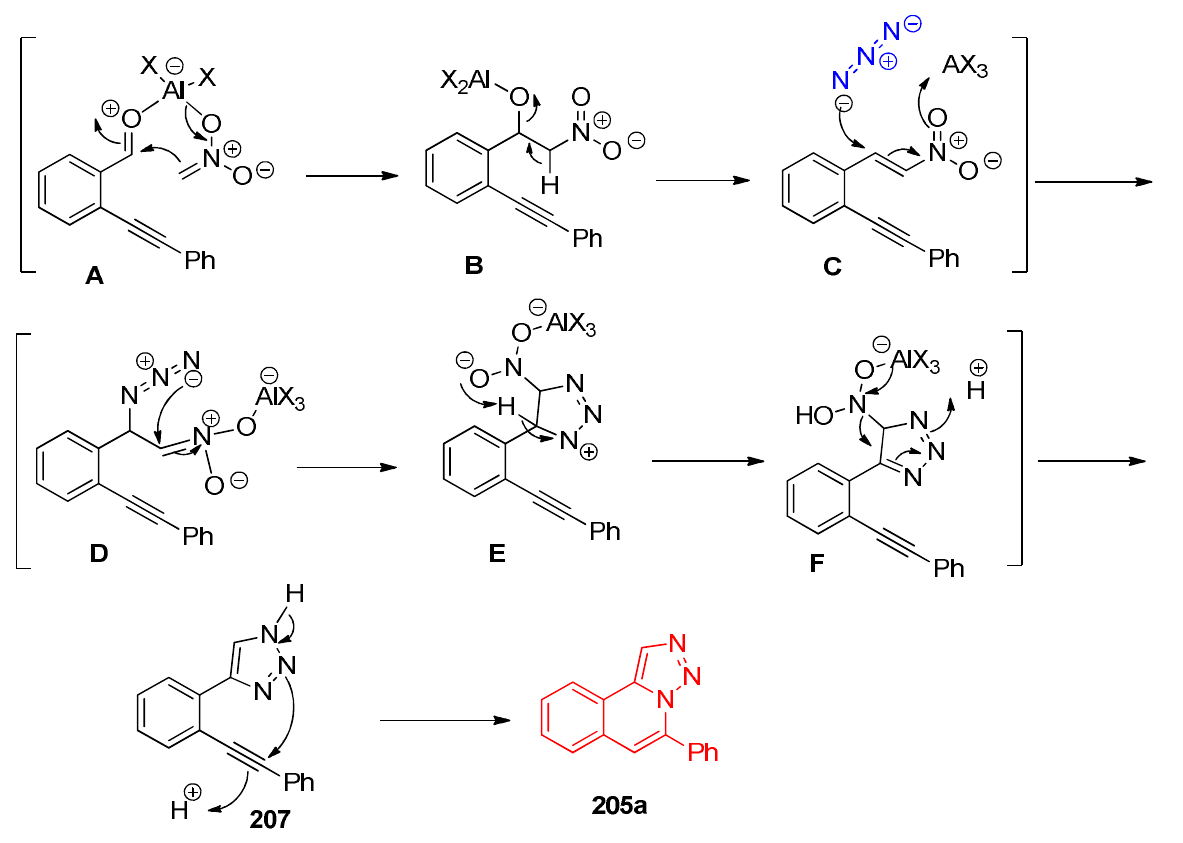
Scheme 78. Mechanistic equations for the formation of 5-phenyl-[1,2,3]triazolo[5,1- a ]isoquinoline 205a